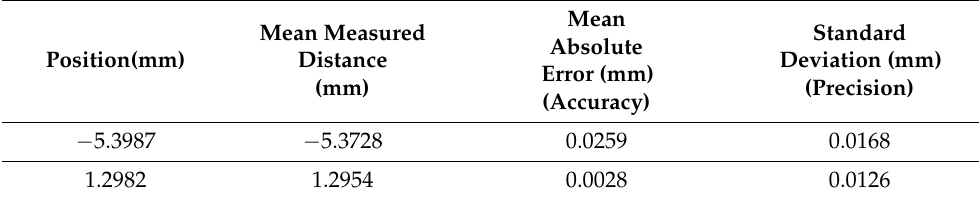
Table 2. Details of the accuracy and precision along the depth direction.